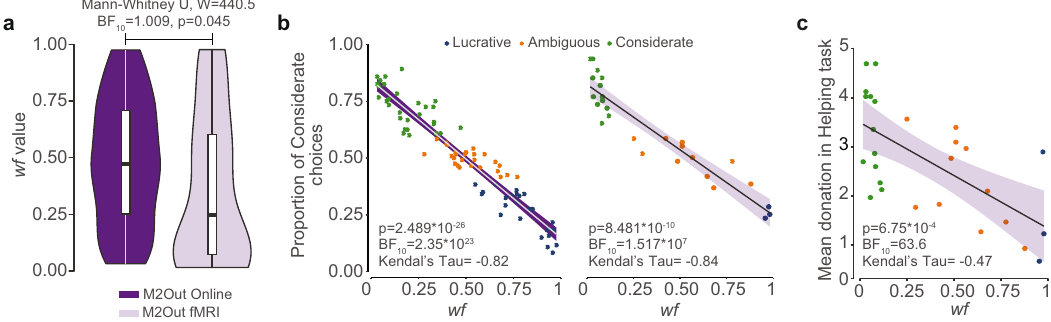
Fig.6| Wf Predictivepower.a Distributionof wf parameterestimatesforM2Outin the Online (purple, only including the fi rst 10 trials of the Con fl ictDropout blocks) or fMRI (lavender, including all trials) across participants. The whisker plots represent the quartiles, dots outliers. The distribution of the other parameters of M2OutcanbefoundinSupplementaryNote§13.Distributionswerecomparedwith a two-tail Mann – Whitney U test. b Relation between wf and proportion of